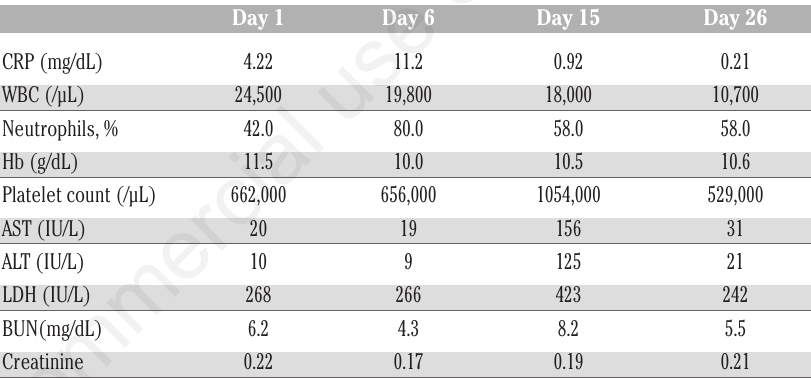
Table 1. Laboratory data after hospitalization.